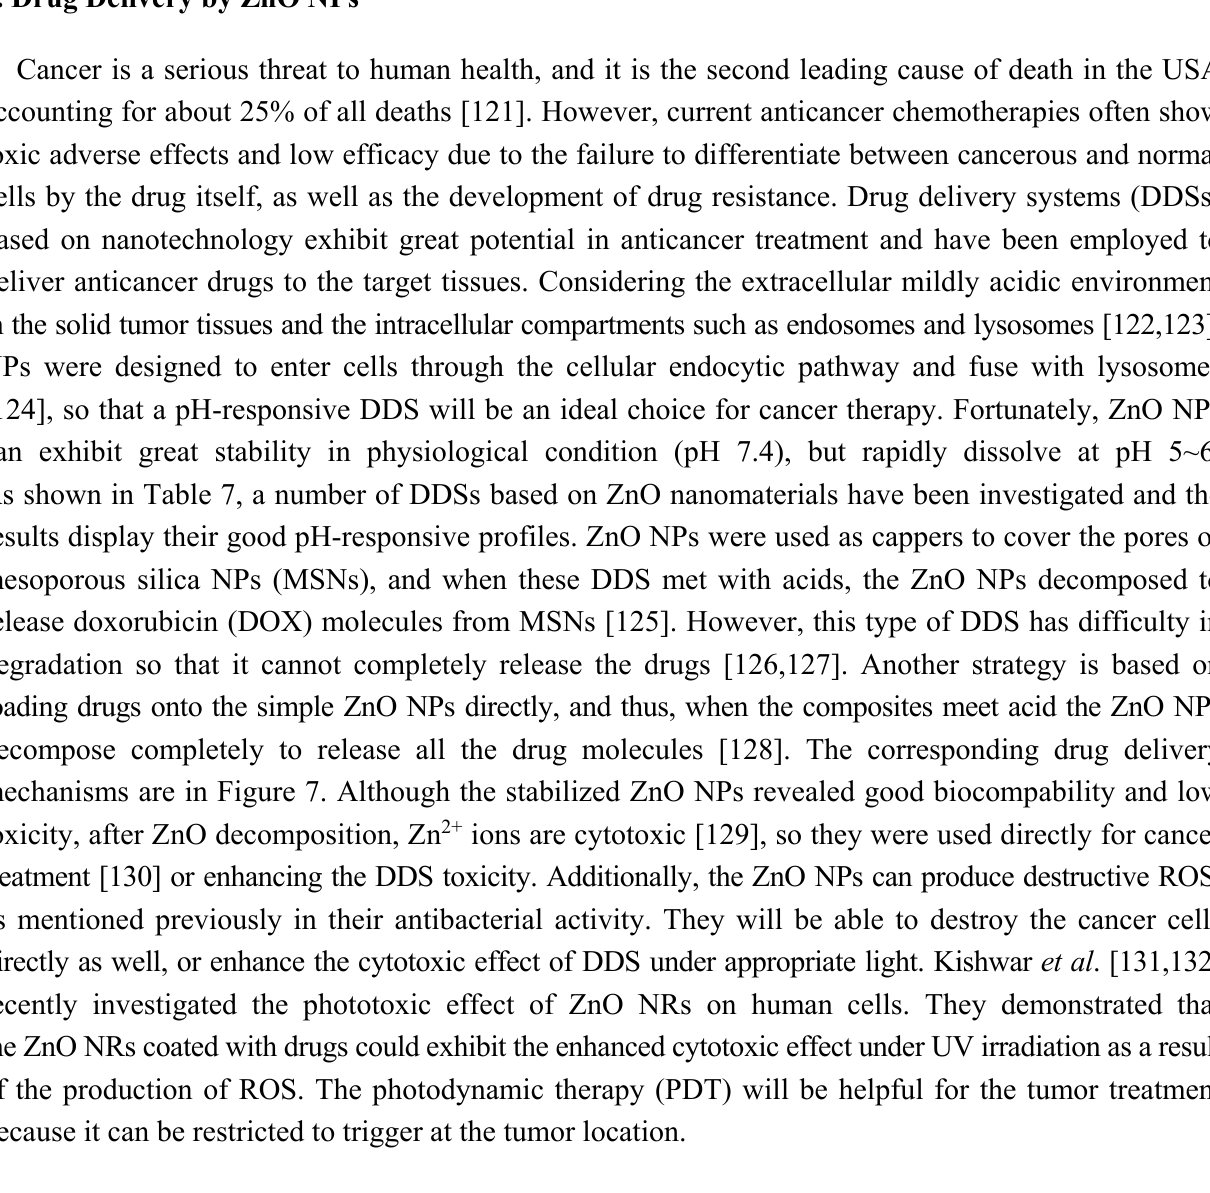
Table 7. Typical researches about drug delivery systems based on the ZnO